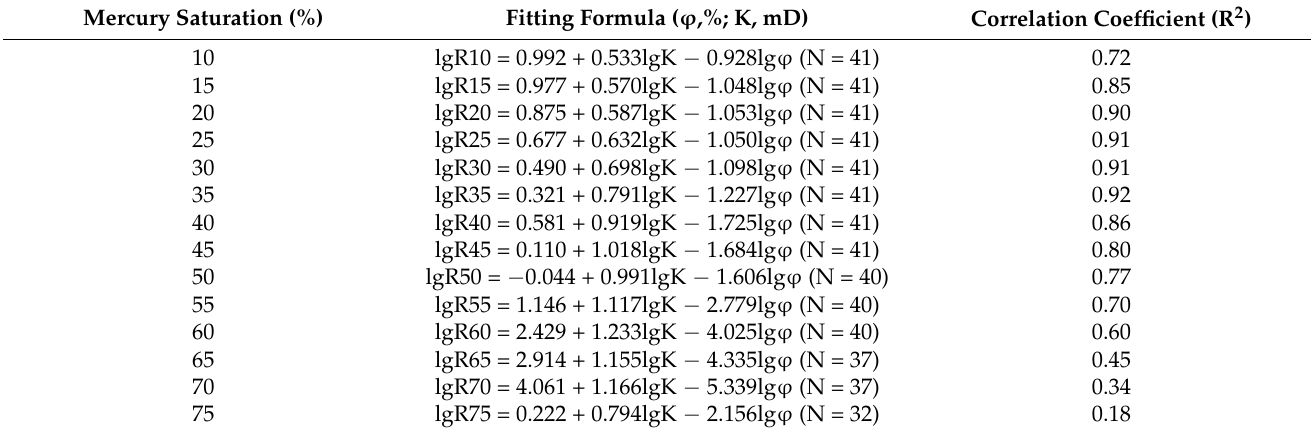
Table 6. The empirical equation of porosity, permeability, and pore throat radius at 10~75% mer- cury saturation.